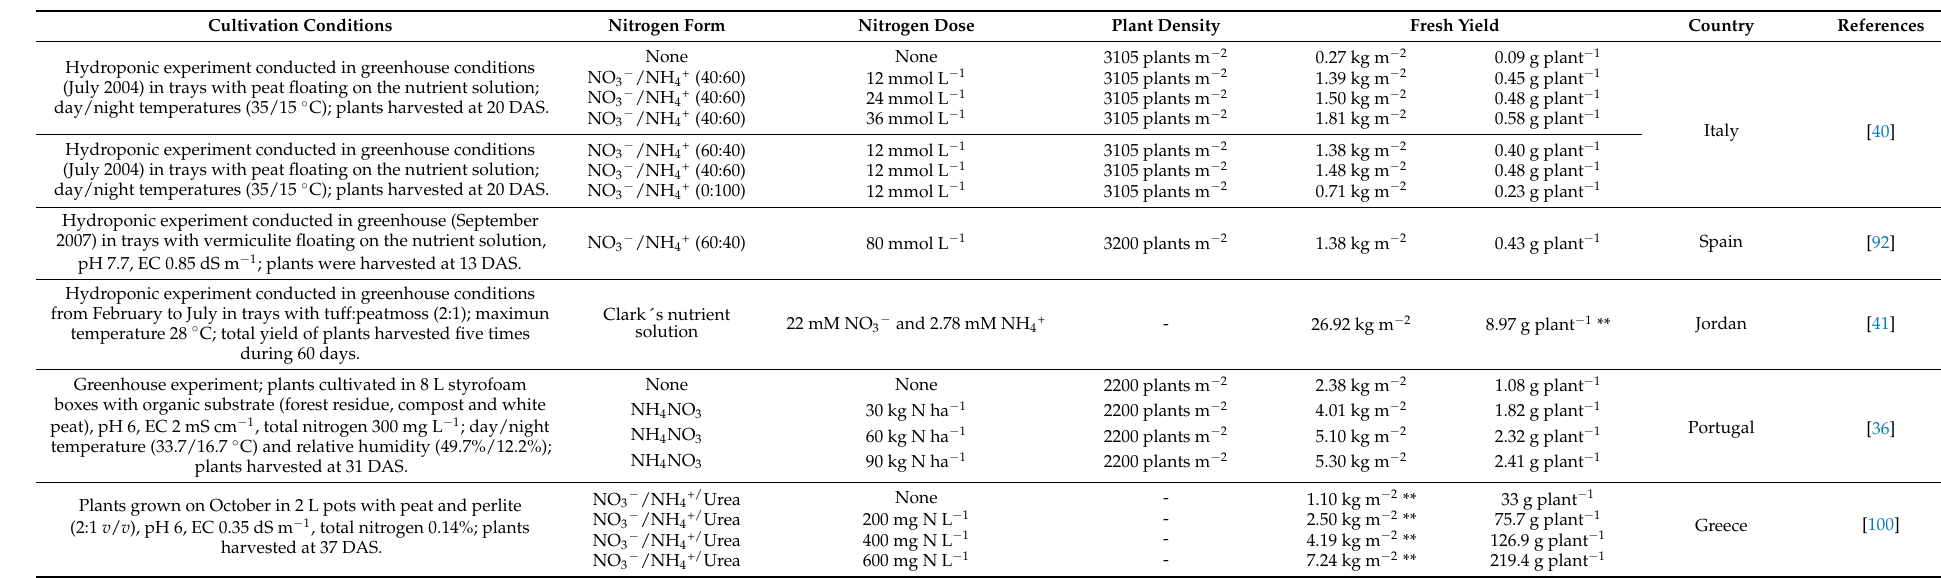
Table 4. The effect of different nitrogen forms and rates in hydroponics and pot experiments with Portulaca oleracea